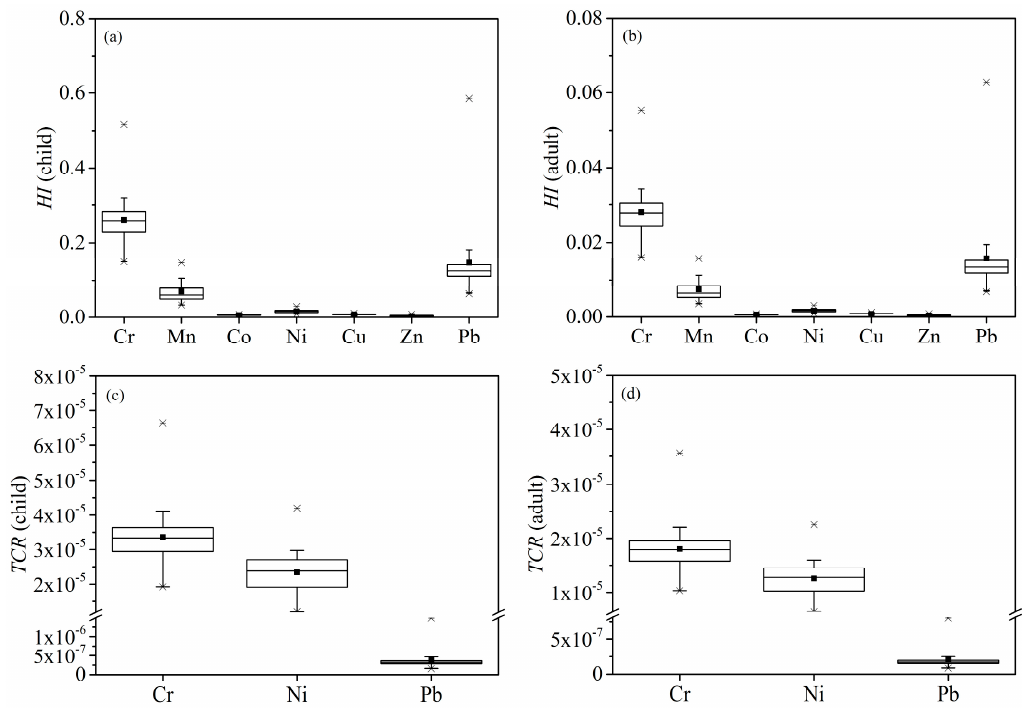
Figure 4. HI and TCR for child and adult of heavy metals. ( a ) HI for child; ( b ) HI for adult; ( c ) TCR for child; ( d ) TCR for adult.